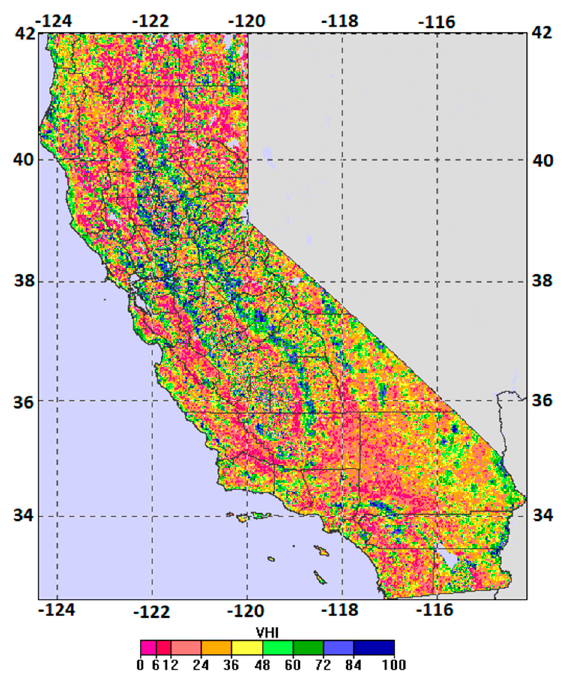
Figure 3. California’s Vegetation Health Index (VHI) geographical distribution from 500 m Suomi National Polar-orbiting Partnership (SNPP) / Visible Infrared Imaging Radiometer Suite (VIIRS) in the period Week 31 (30 July–5 August), 2014.